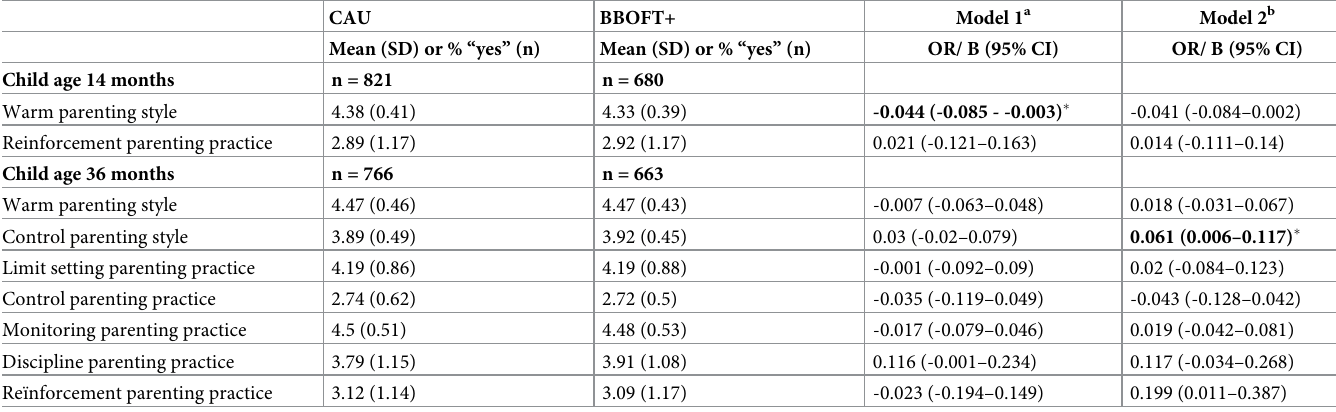
Table 5. Intervention effects on general parenting styles and parenting practices at child age 14 and 36 months.